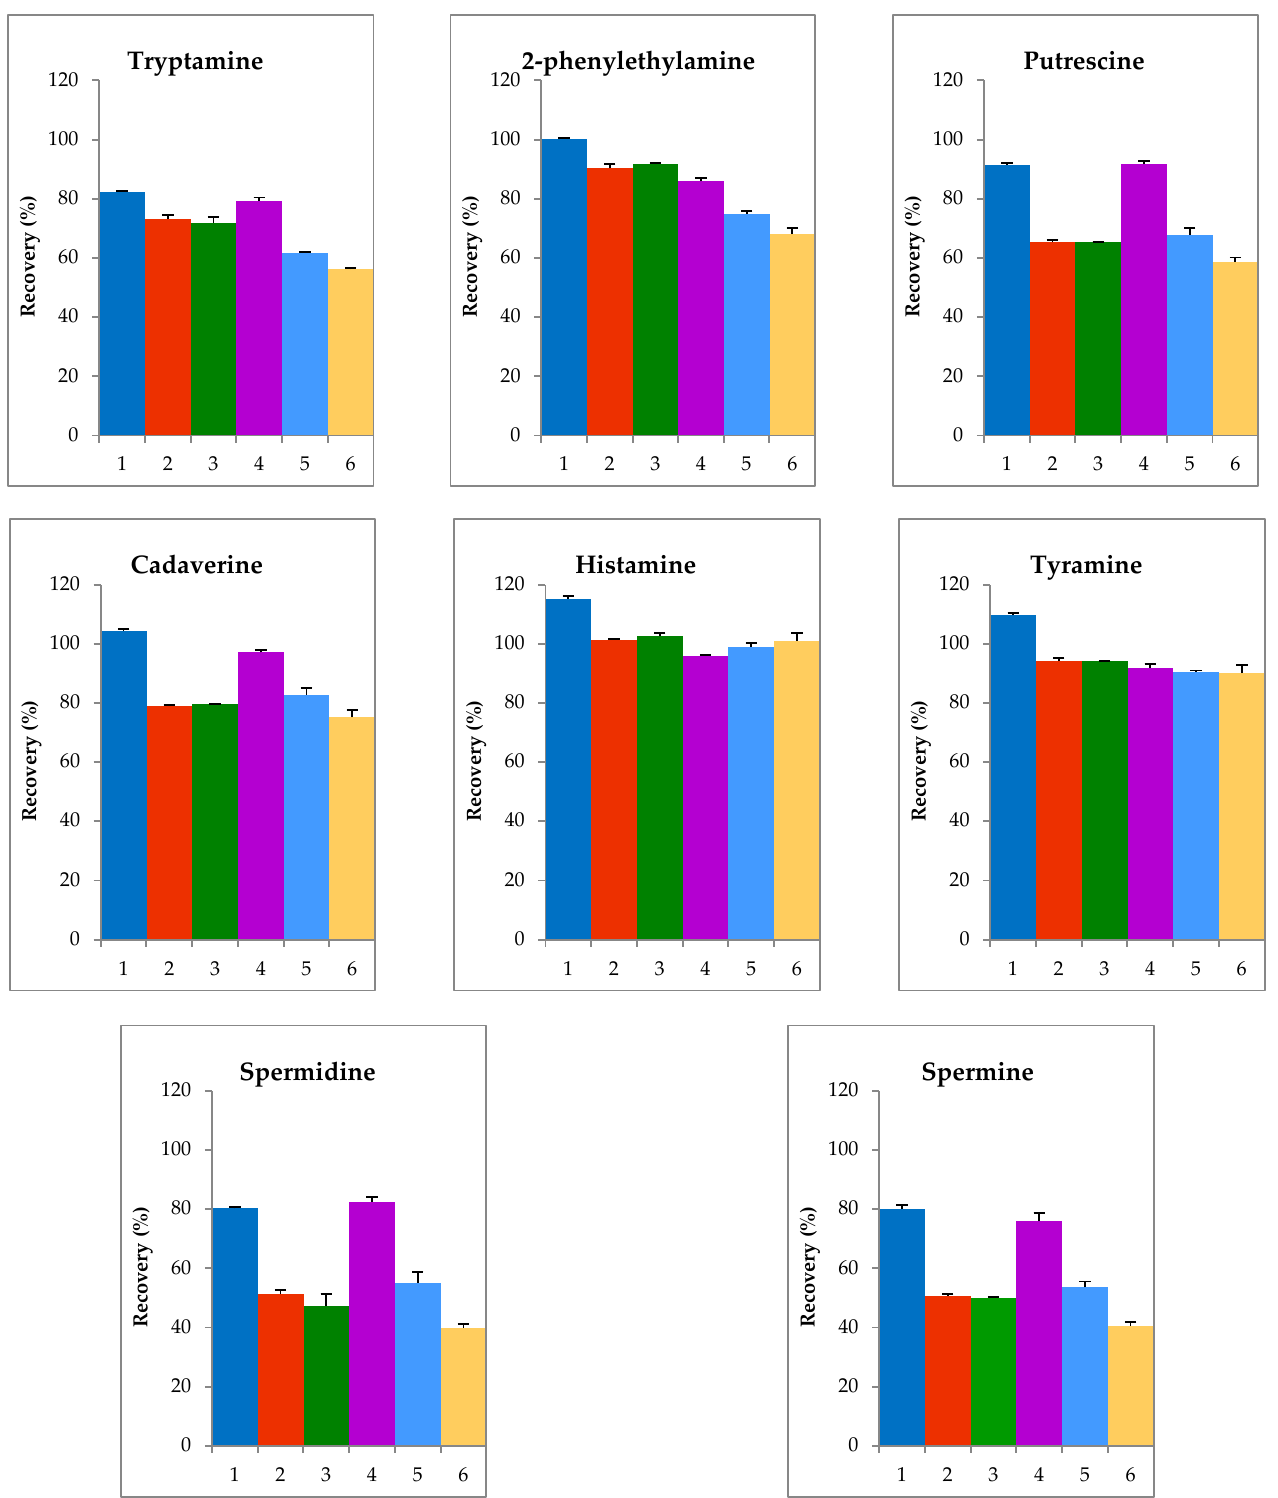
were obtained when perchloric acid at concentration of 0.2 M as the extraction solvent was applied.